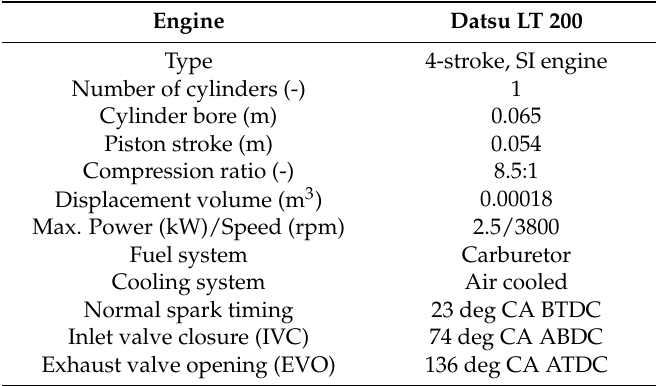
Table 2. Basic geometrical and operational data of the test engine.